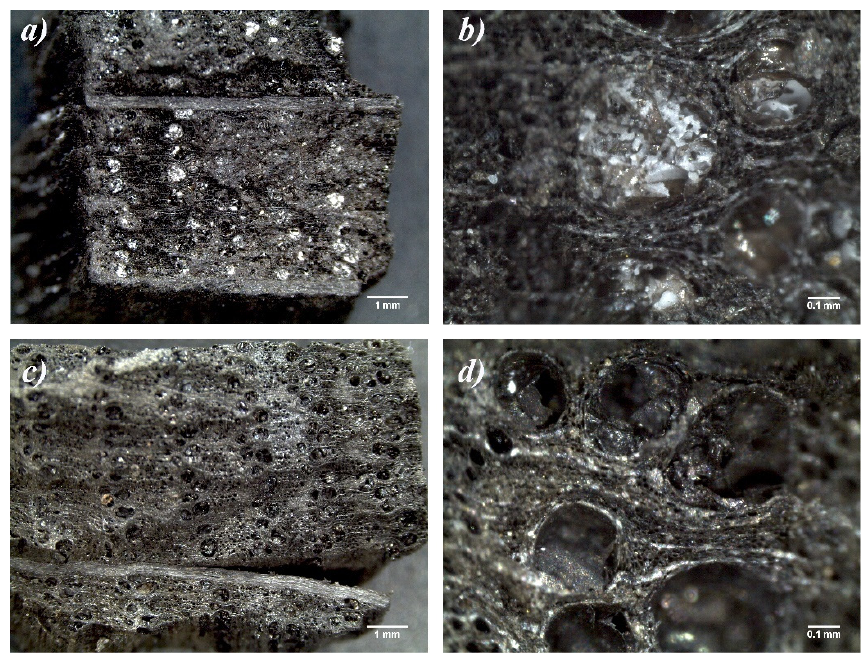
Figure 9. Optical stereomicroscopy images referred to the untreated dry wooden fragments before PEG washings ( a , b ) and after PEG washings ( c , d ).